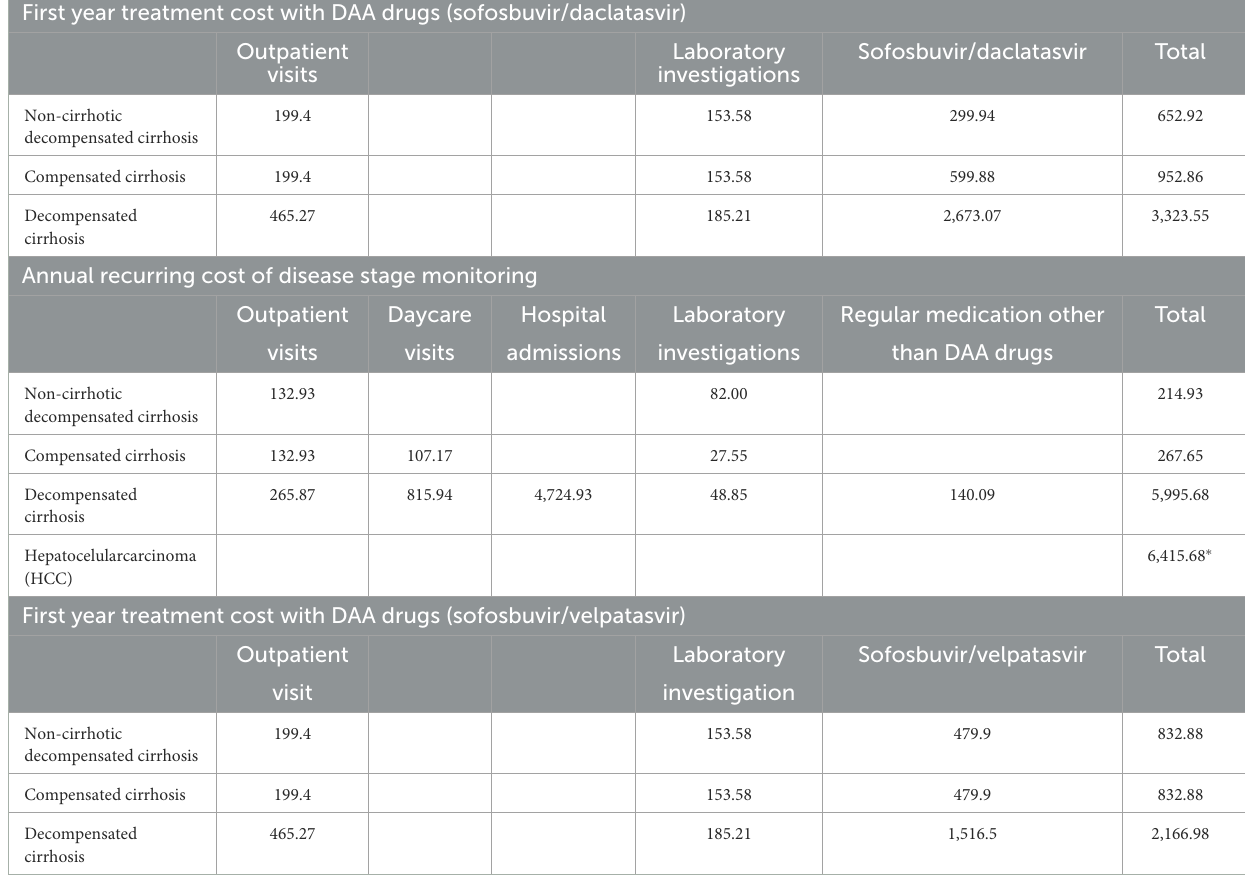
TABLE 2 Annual treatment cost (1st year treatment cost) with DAA drugs and disease stage management-related cost (USD, 2021). First year treatment cost with DAA drugs